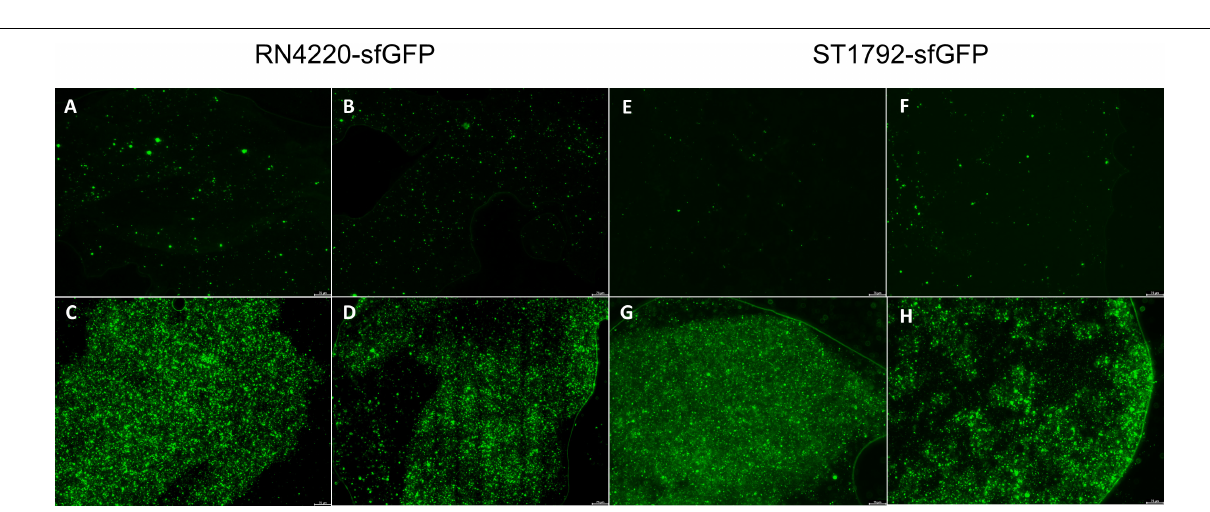
Frontiers in Microbiology |